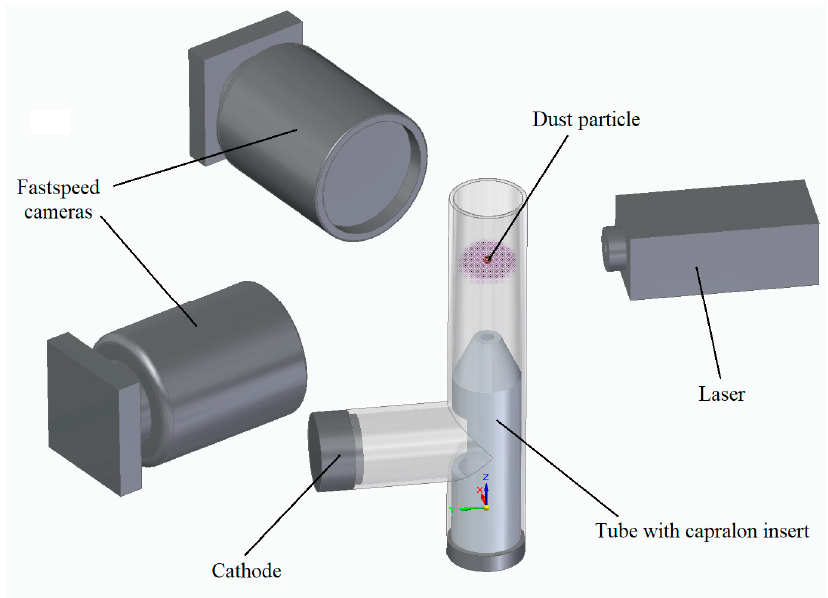
Figure 6. Scheme of the experimental setup.